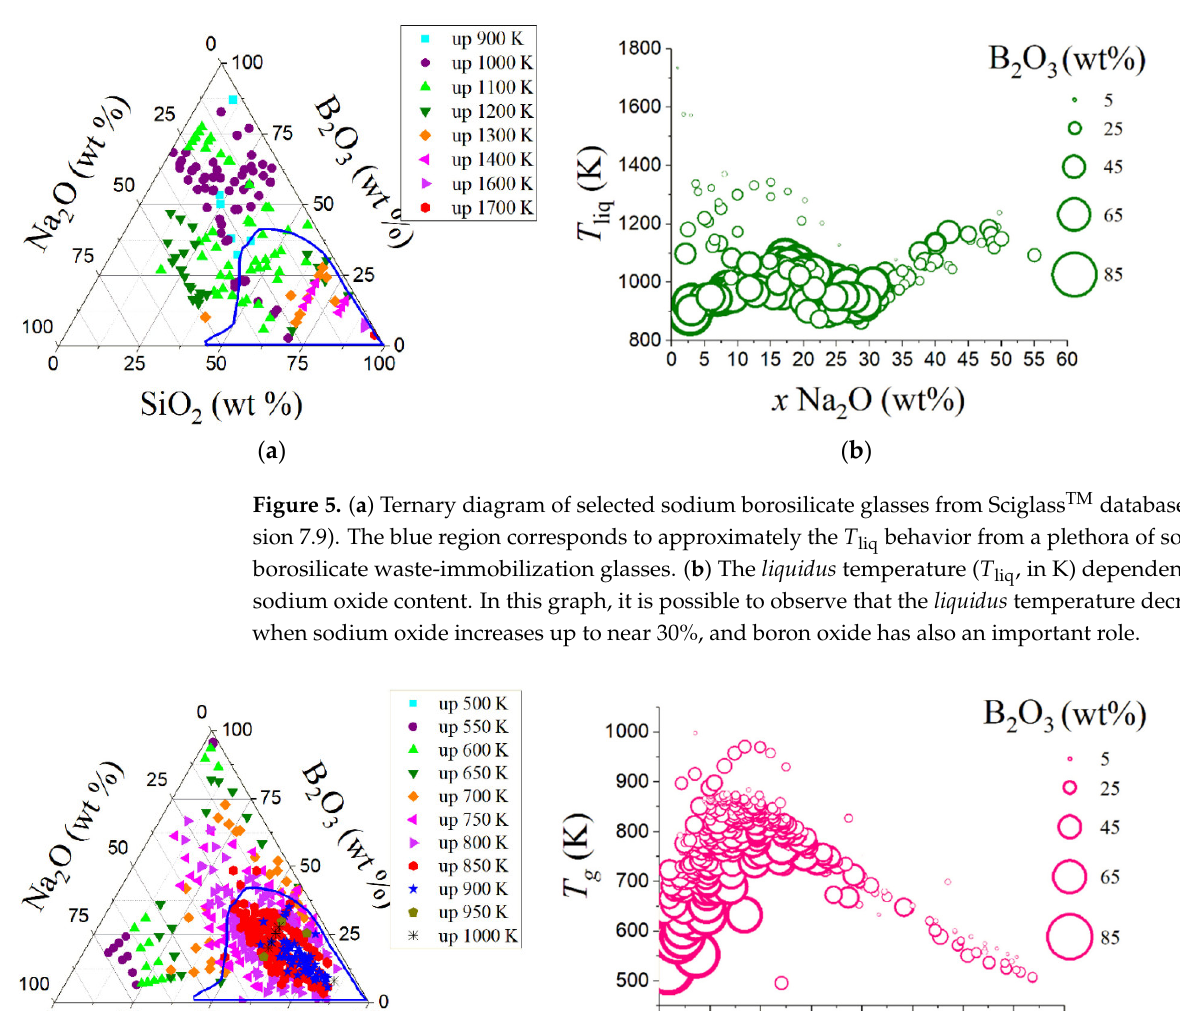
( b ) Figure 7. ( a ) Ternary diagram of selected sodium borosilicate glasses from Sciglass TM database (version 7.9). The blue region corresponds to approximately the density behavior from a plethora of sodium borosilicate waste-immobilization glasses. ( b ) The density dependence on sodium oxide content at 20 °C. Density shows a high increase, from 1.8 to 2.5, changing the sodium oxide content up to 30 wt%, and maintaining this fixed value for higher sodium concentrations. Figure 8a shows the ionic resistivity ρ of 115 NBS glasses at 150 °C. The resistivity shows a strong dependence on sodium content, as expected due to its ionic conduction, but boron contents also influence it. Figure 8b shows how resistivity decreases with increasing Na 2 O contents, and for a fixed sodium oxide content, resistivity in general also decreases with decreasing B 2 O 3 contents [113]. The design and operation of electric glass